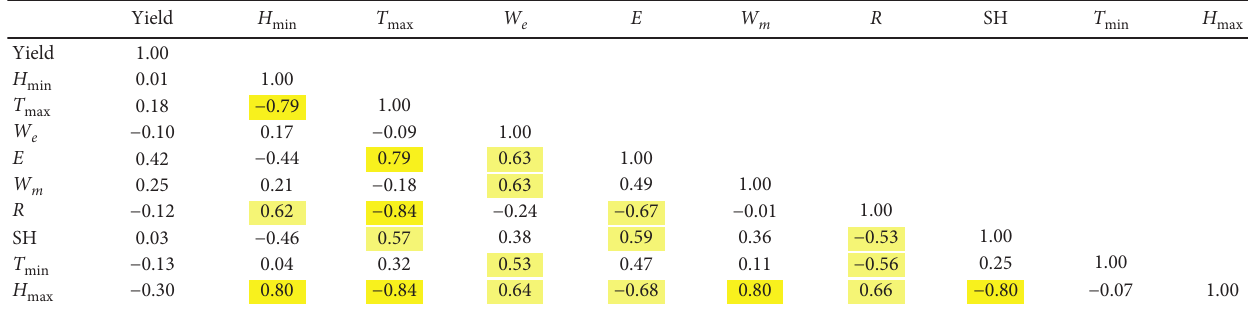
Table 4: Spearman’s correlation